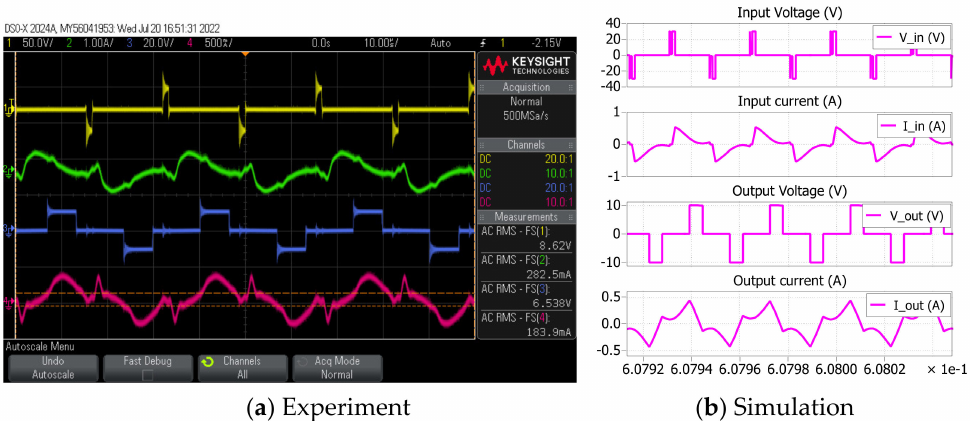
Figure 21. Inverter/rectifier AC voltage and current waveforms at Vo = 10 V, R ac = 38 Ω with R dc = 200 Ω